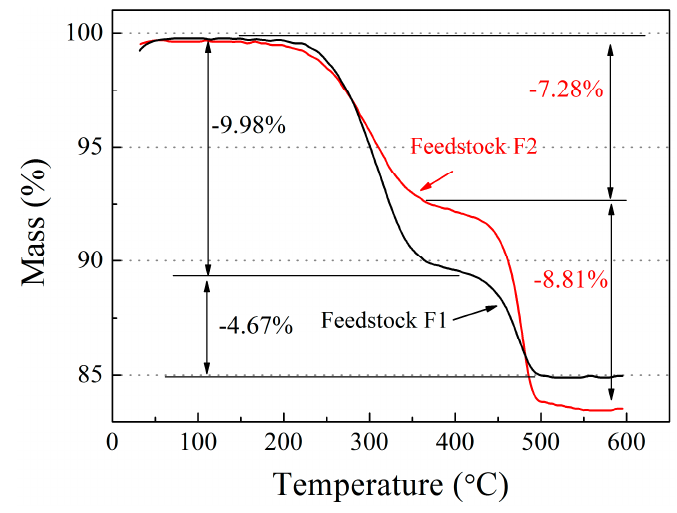
Figure 5. TGA (thermogravimetric analysis) results of the feedstocks. Table 3. Impurity levels of the raw powder and debound parts.